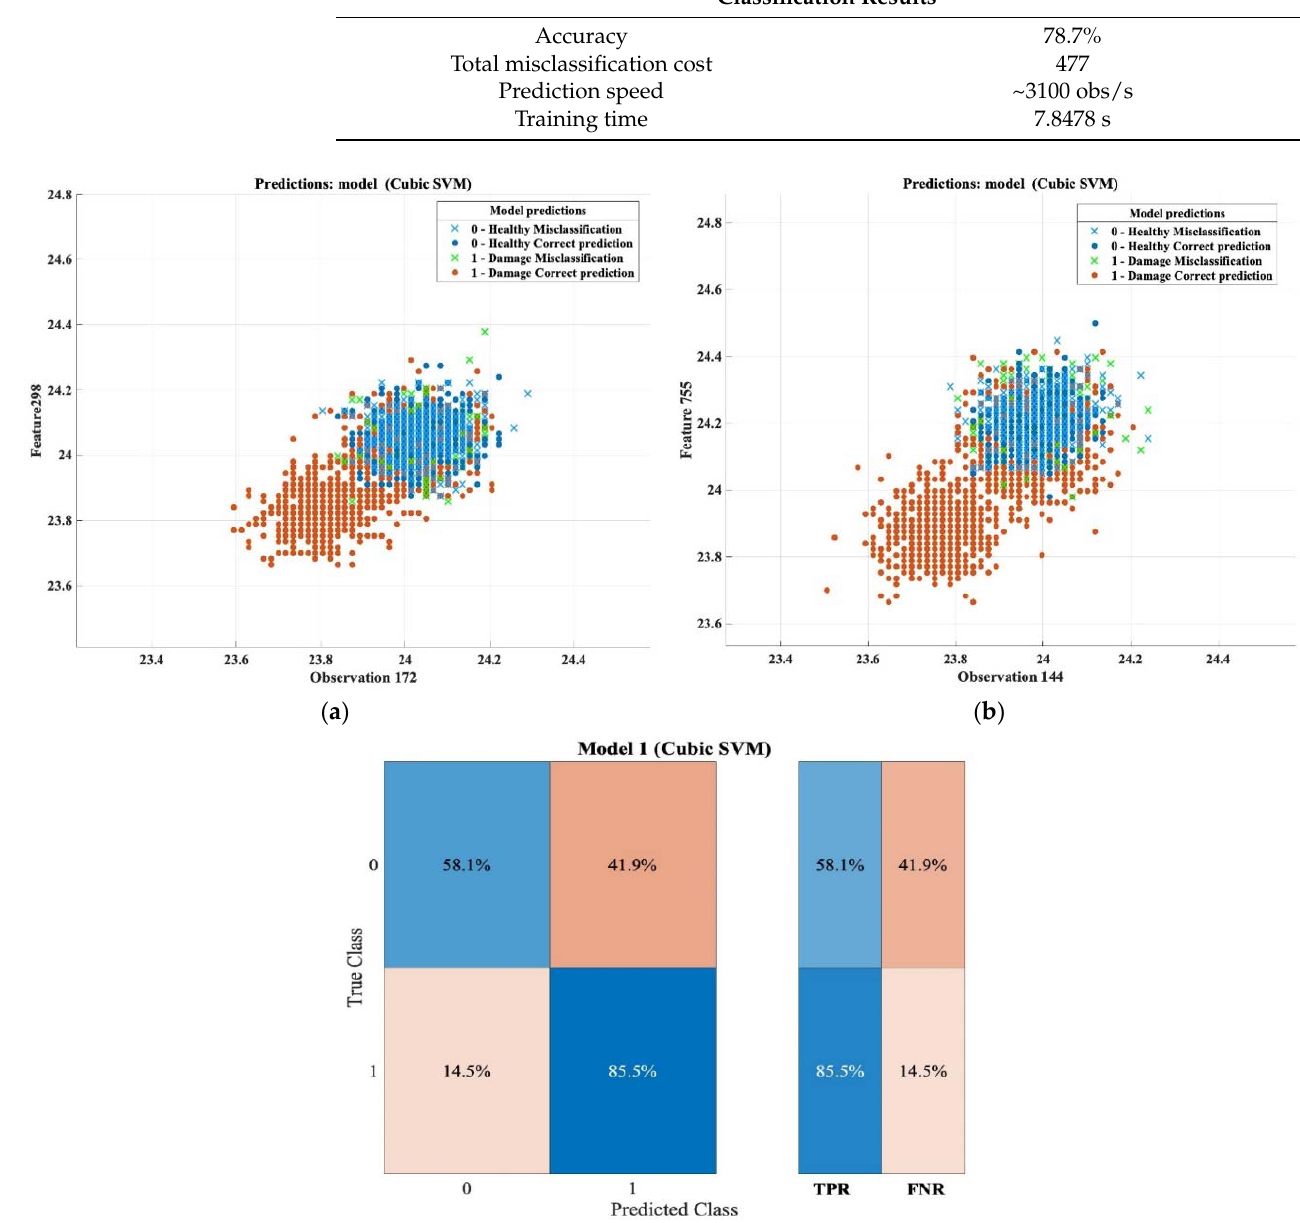
Table 16. Classification results for thick samples based on transmission mode.